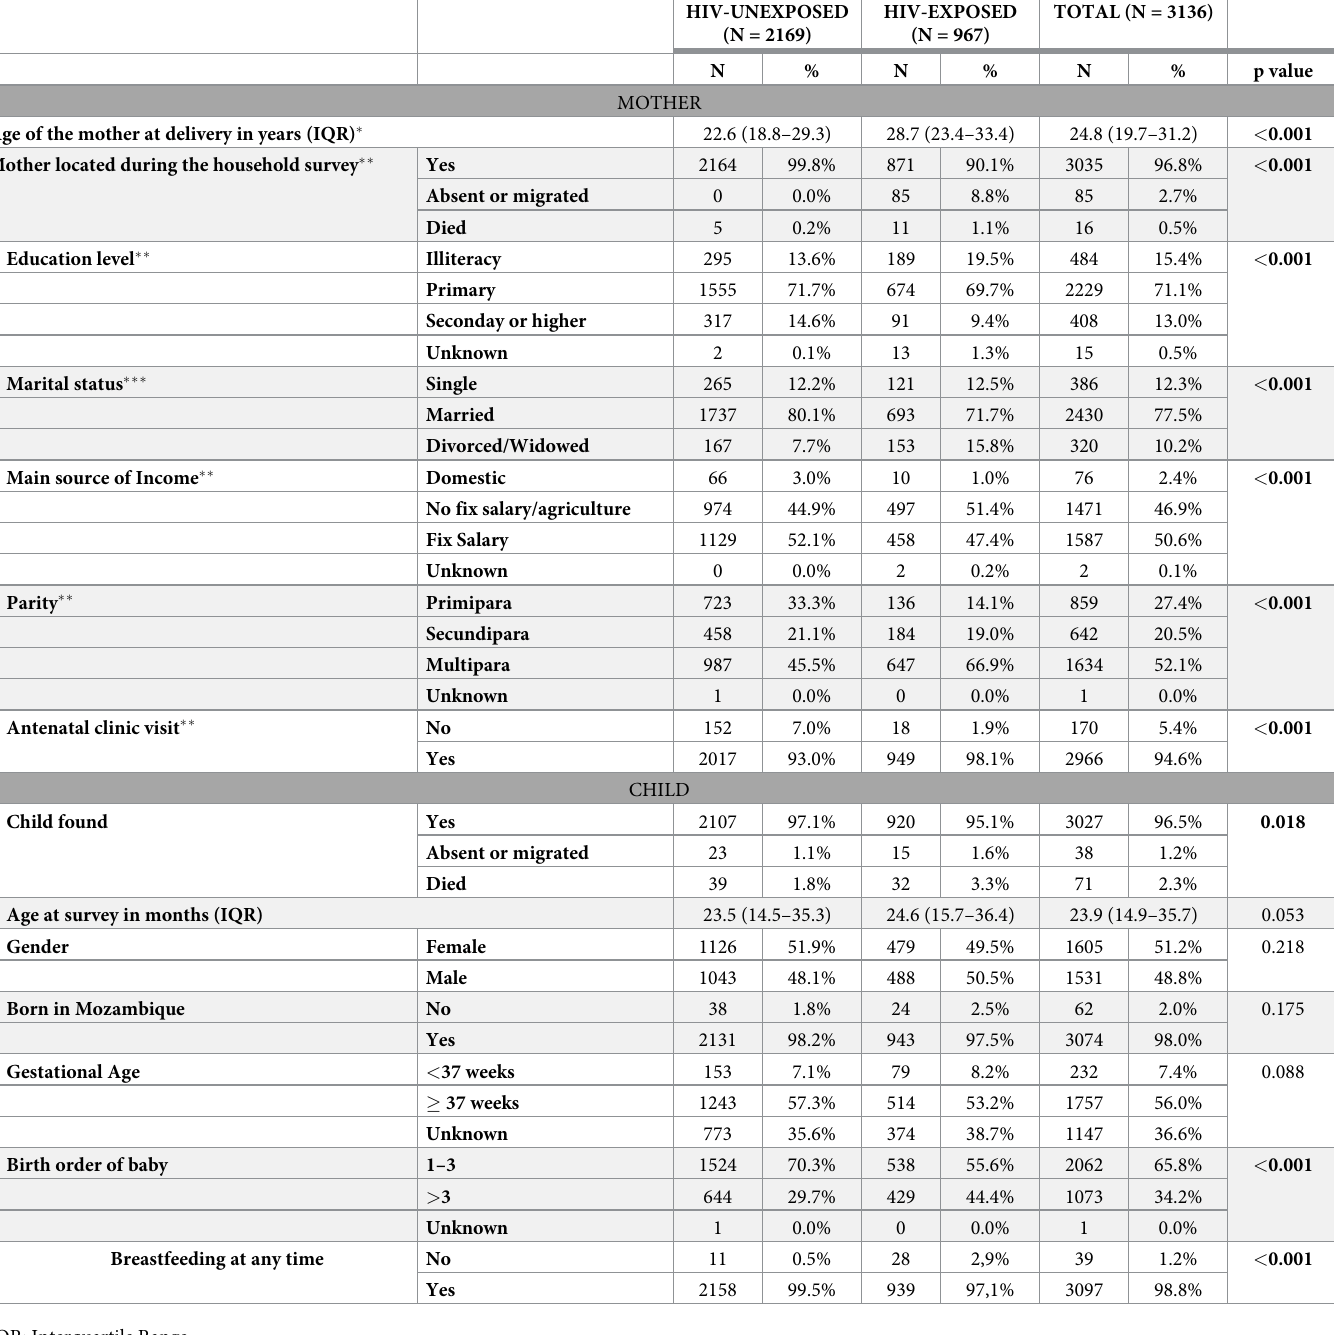
Table 1. Characteristics of HIV-exposed and HIV-unexposed children at the time of the survey (n = 3136). The 350 children for whom HIV exposure could not be ascertained are not